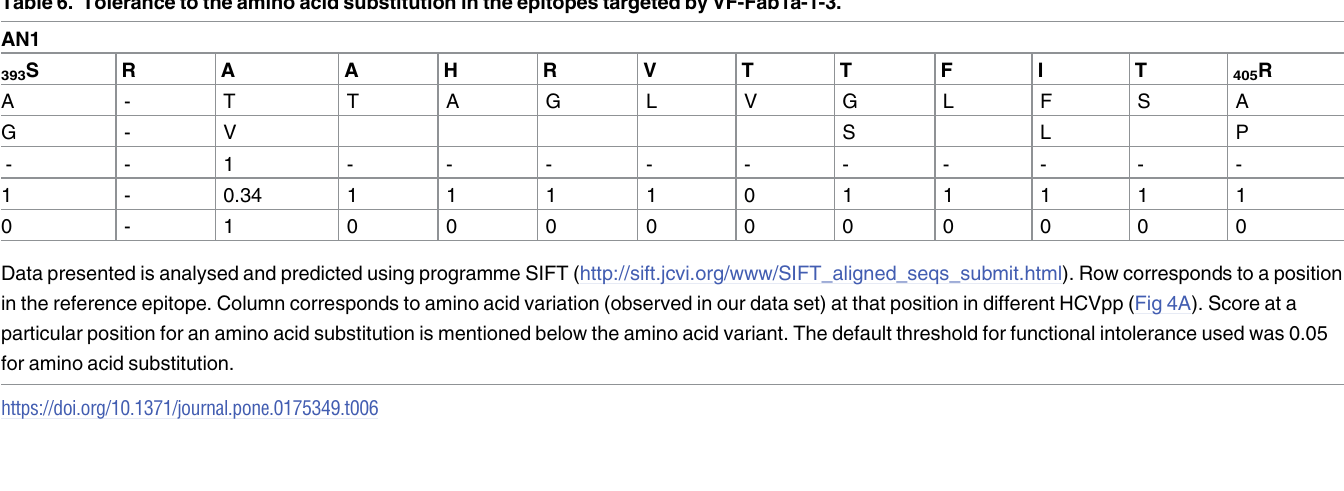
construct (an appropriate retrovirus backbone) iii) balancing the delivery of plasmids encod- ing the packaging vector and glycoproteins [14]. We also acknowledge that the E1E2 expressed by expression vector and proper folding of the glycoprotein could also influence the infectivity of the HCVpp. We made similar observations in terms of infectivity of HCVpp (Fig 1). How- ever, we observed that HCVpp1b-1-2 and HCVpp1b-1-3 were closely related yet differed in their infectivity. Recently, Urbanowicz et al . (2016) have shown that difference in the infectiv- ity of closely related E1E2 clones is due to isolate specific mutations in these genes [14]. Our site directed mutagenesis study showed that mutations in the HVR1 of E2 were restricted and